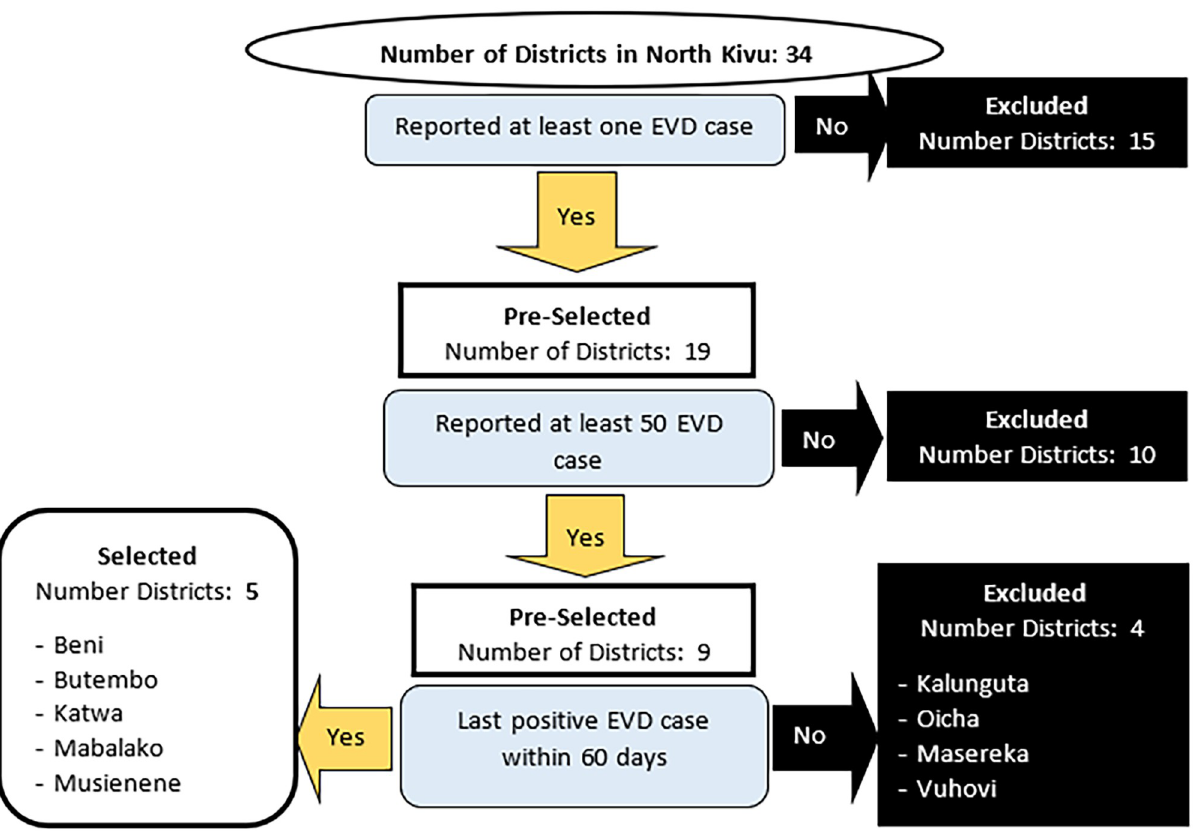
Fig 2. Selection scheme for the health districts included in the